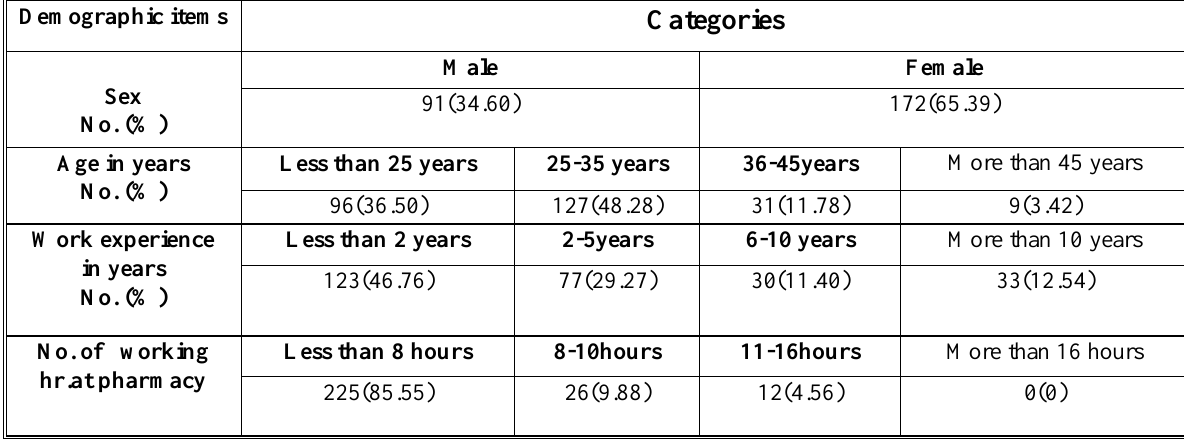
Table 1. Demographic data for participants (n=263)